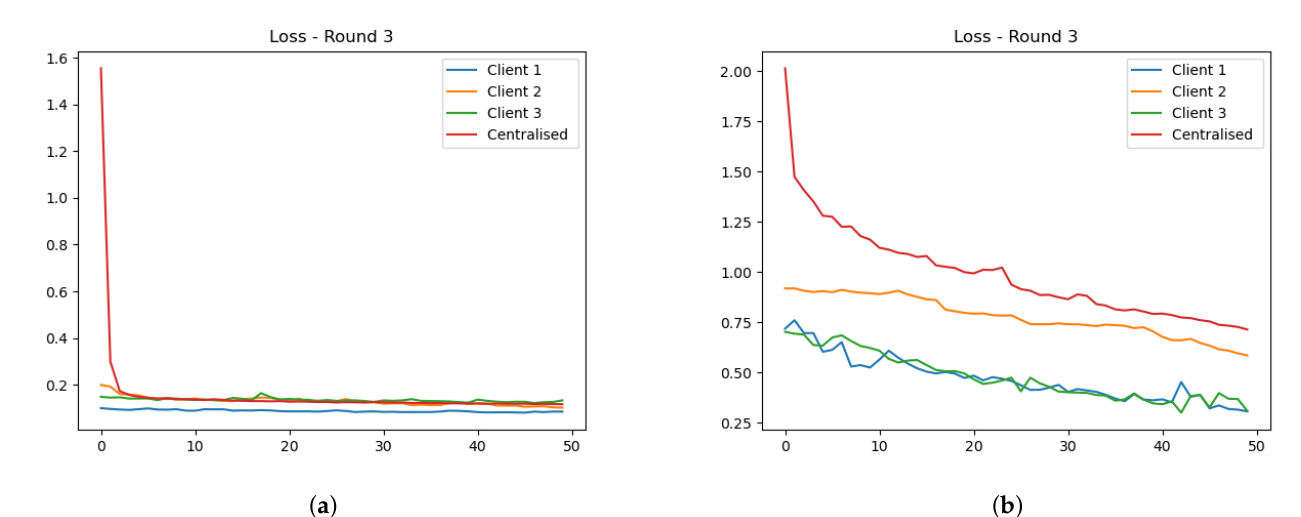
Figure 5. FedUnet model performance. ( a ) CityScapes dataset; ( b ) Chennai land use